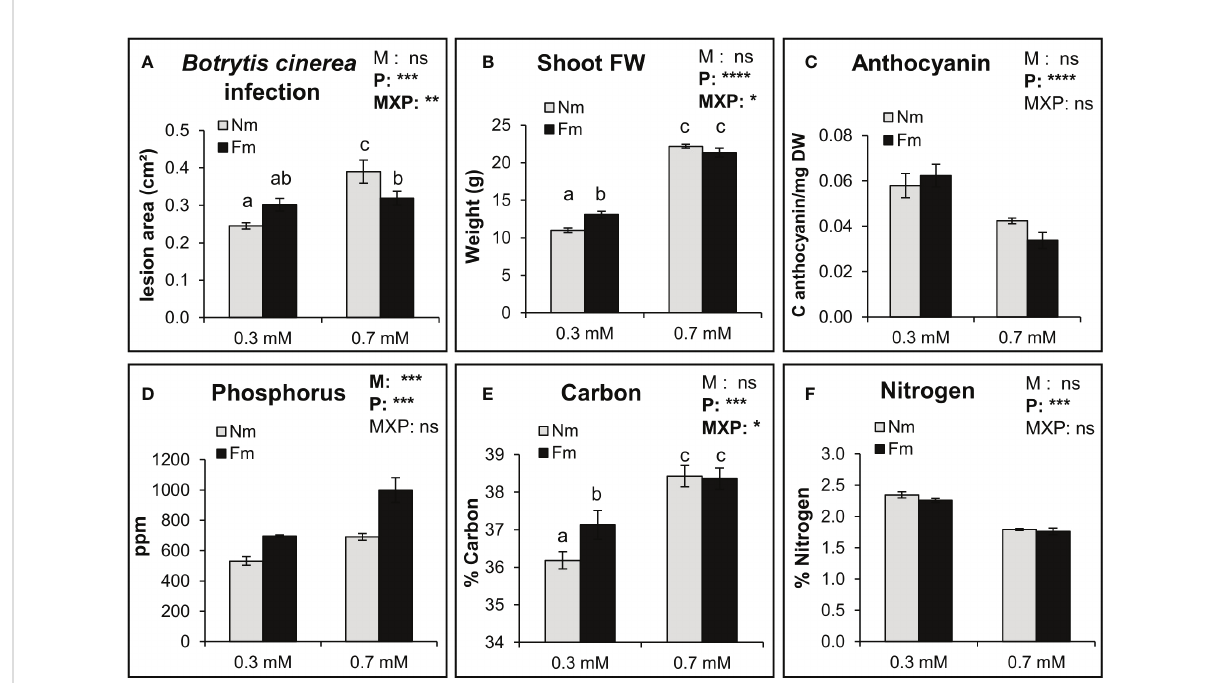
FIGURE 3 Impact of P fertilization and mycorrhization on the nutritional value of tomato leaves. Botrytis cinerea infection, shoot biomass, anthocyanin, and nutrient contents in tomato leaves of non-mycorrhizal (Nm) and mycorrhizal tomato plants colonized by ( F ) mosseae (Fm). Plants were fertilized by two P concentrations: 0.3 mM and 0.7 mM P. (A) Diameter of necrotic lesions 3 days post inoculation with (B) cinerea in detached adult leaves from tomato (n=9). (B) Shoot fresh weight (n=9), (C) anthocyanin (n=6), (D) phosphorus (n=6), (E) carbon (n=6) and (F) nitrogen (n=6) content were measured in tomato plants 6 weeks post mycorrhizal inoculation. Data represent the means of n independent biological replicates ± SD. Two-way ANOVA with mycorrhizal (M) and P treatments (P) as factors, was performed, and the signi fi cance of the factors and their interaction is indicated in the upper right corner of each graph. Different letters represent statistically signi fi cant differences (ANOVA, Fisher ’ s Least Signi fi cant Difference (LSD) test; p <0.05) where the interaction between factors was observed. Otherwise, asterisks denote signi fi cant effect of a factor and their interaction. ns: no signi fi cant; *: p<0.05; **: p<0.01; ***: p<0.001; ****: